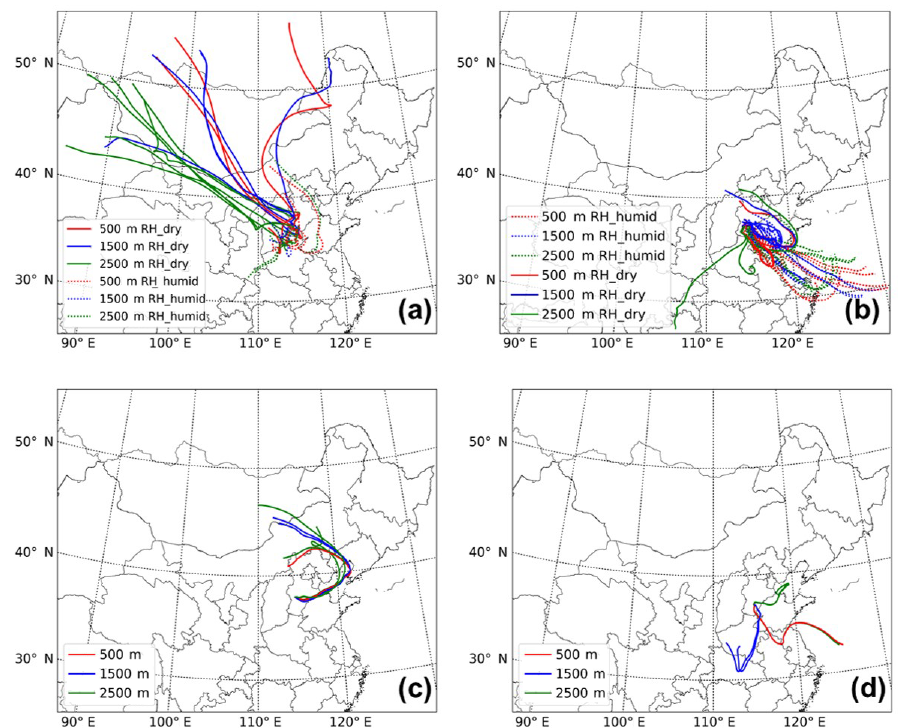
Figure 9. 72h HYSPLIT back trajectories for the cases when the PBL was (a) clean, (b) polluted in the lower PBL, (c) polluted in the upper PBL in the flight on 2 June, and (d) polluted in multiple layers of the PBL in the flight on 6 June. Trajectories at different levels under dry (solid lines) and humid (dashed lines) conditions are shown: 500m (red), 1500m (blue), and 2500m (green) above mean sea